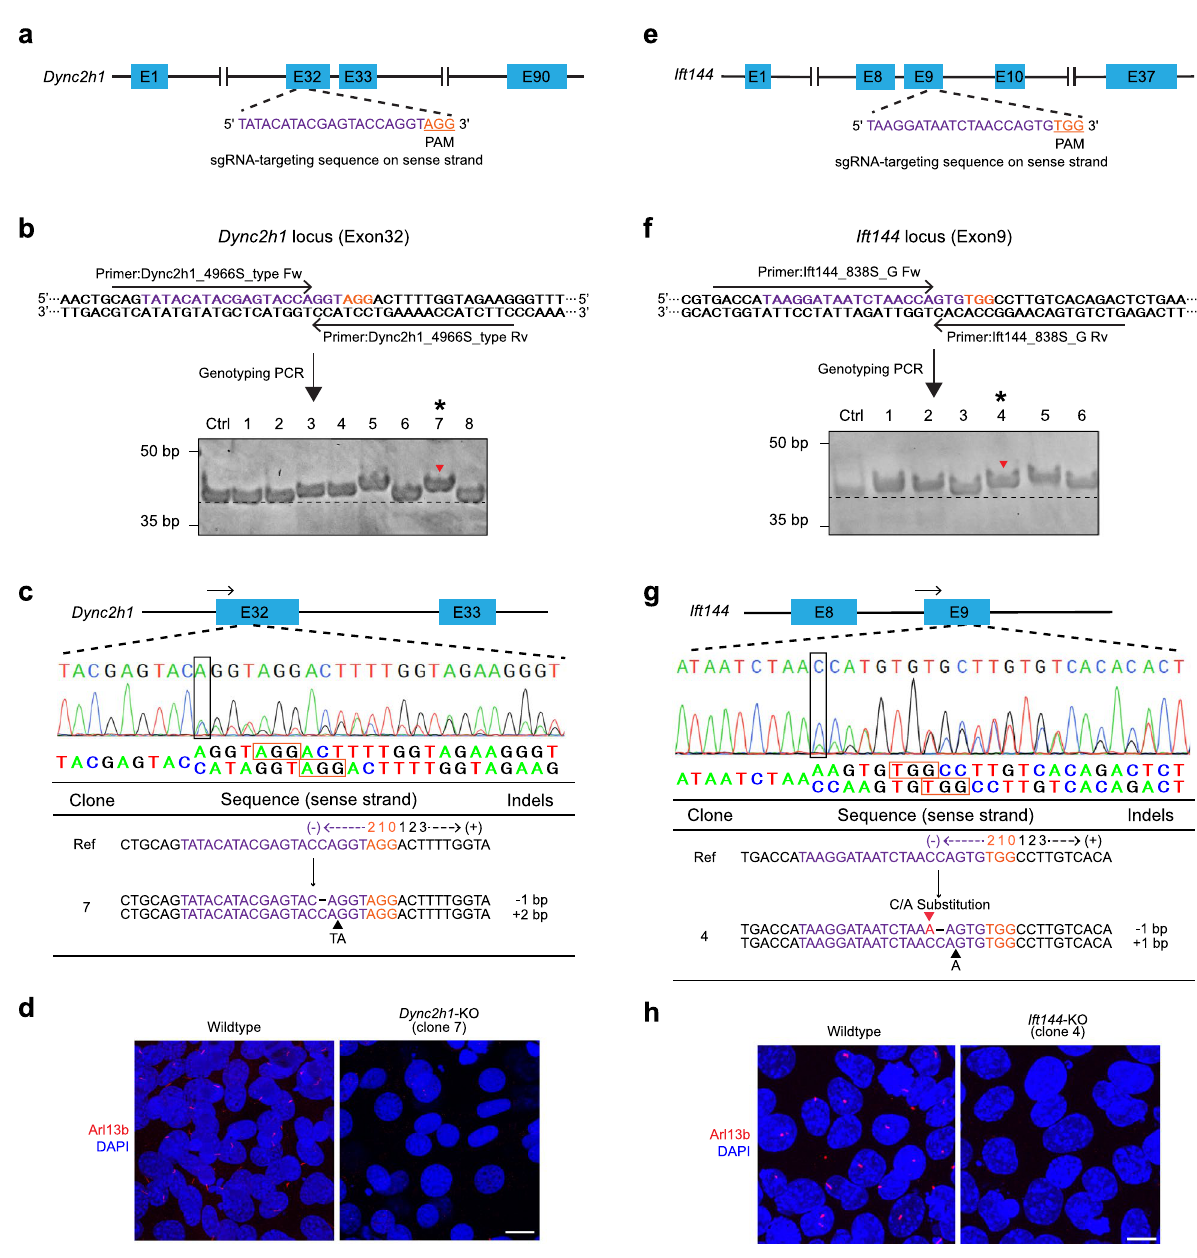
Figure 2. Detection of insertion mutations via DST-PCR ( a ) Scheme of the Dync2h1 guide RNA targeting exon 32 in the murine Dync2h1 gene. ( b ) DST-PCR for screening mutations. Upper panel: The arrows indicate the locations of the DST-PCR primers (see Table 1). Bottom panel: TBE-high-resolution-PAGE of DST-PCR products. Lane Ctrl: PCR product (40-bp) amplified from the genomic DNA of wild-type unedited cells. Several clones including clone #7 (*) show fragments mobility upper shift (red arrowhead). ( c ) Sanger sequencing of the PCR products of clone #7 (* in panel b) around the PAM sequence (orange rectangle). Split sequences were shown under the spectrum. Start of split sequences are highlighted as black rectangle. The arrows indicate the locations of the sequencing primers (see Table 1). ( d ) Fluorescence microscopy images showing cells with primary cilium stained for the ciliary marker (Arl13b; red) and the nucleus (DAPI; blue) in wild-type and clone #7. Scale bar, 10 μm. ( e ) Scheme of the Ift144 guide RNA targeting exon 9 in the murine Ift144 gene. ( f ) DST-PCR for screening mutations. Upper panel: The arrows indicate the locations of the DST-PCR primers (see Table 1). Bottom panel: TBE-high-resolution-PAGE of DST-PCR products. Lane Ctrl: PCR product (41-bp) amplified from the genomic DNA of wild-type unedited cells. Several clones including clone #4 (*) show fragments mobility upper shift (red arrowhead). ( g ) Sanger sequencing of the PCR products of clone #4 (* in panel f ) around the PAM sequence (orange rectangle). Split sequences were shown under the spectrum. Start of split sequences are highlighted as black rectangle. The arrows indicate the locations of the sequencing primers (see Table 1). ( h ) Fluorescence microscopy images showing cells with primary cilium stained for the ciliary marker (Arl13b; red) and the nucleus (DAPI; blue) in wild-type and clone #4. Scale bar, 10 μm. The 20-bp sgRNA and 3-bp PAM sequences are highlighted in magenta and orange respectively. Wild-type sequence (Ref), base deletion (−), base insertion ( ▲ ), base substitution ( ▲ , red). Original gels are presented in Supplementary Raw Data. Created in Adobe Illustrator CC V26.2.1 (https:// adobe. com/ produ cts/ illus